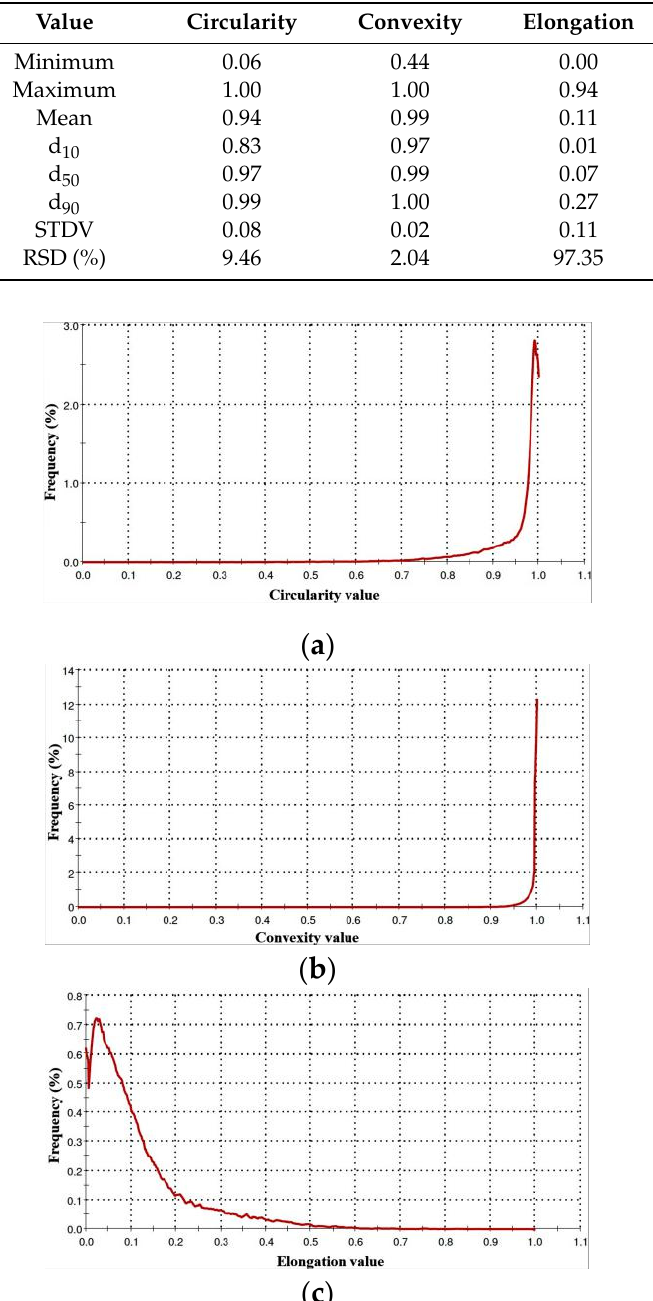
Table 3. Powder examination via shape parameters.